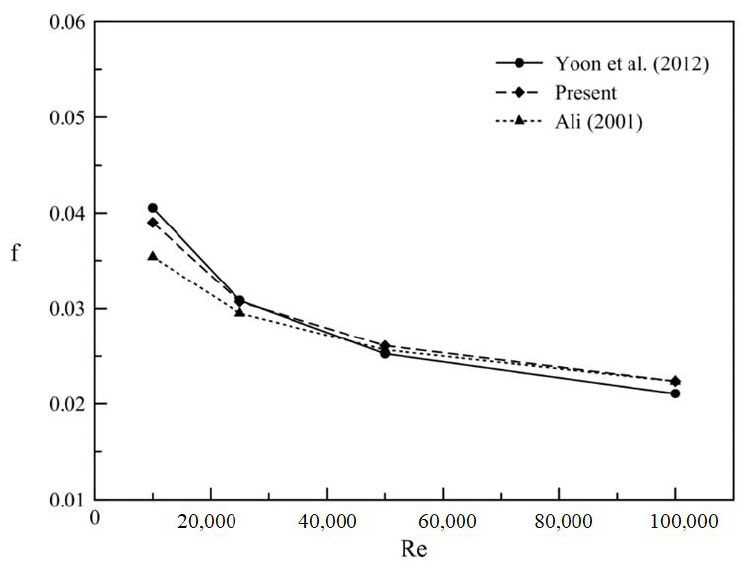
Figure 3. Friction factor for different Reynolds numbers at d/D = 0.04167.